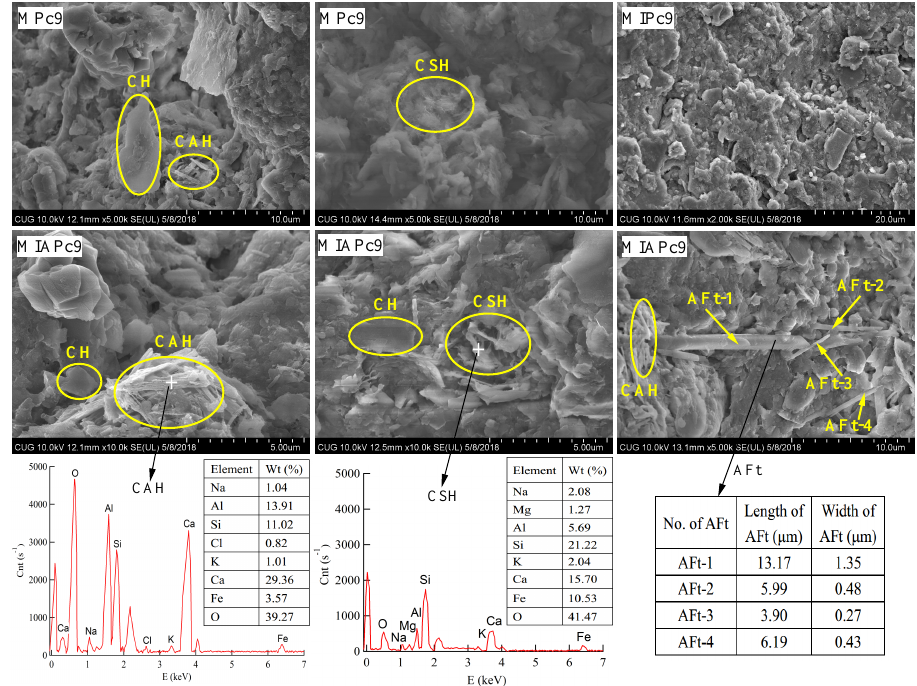
Figure 9. SEM micrographs and EDS spectrums of new substances formed in the chemical solidifica- tion